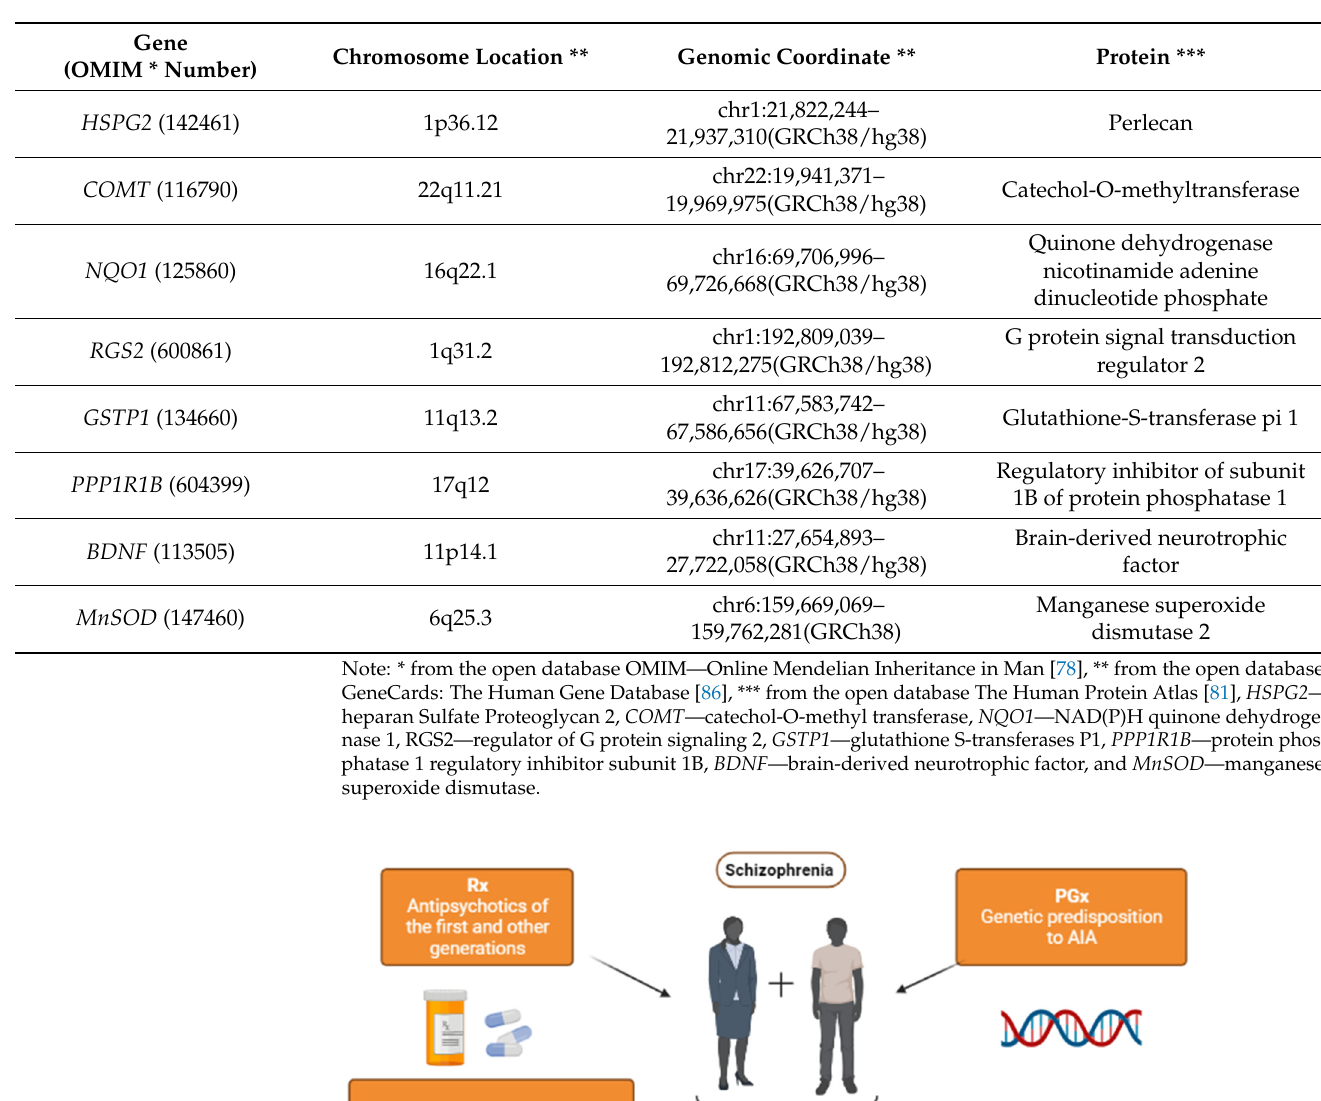
Table A9. Candidate genes encoding key targets/enzymes of antipsychotics in the central nervous system.